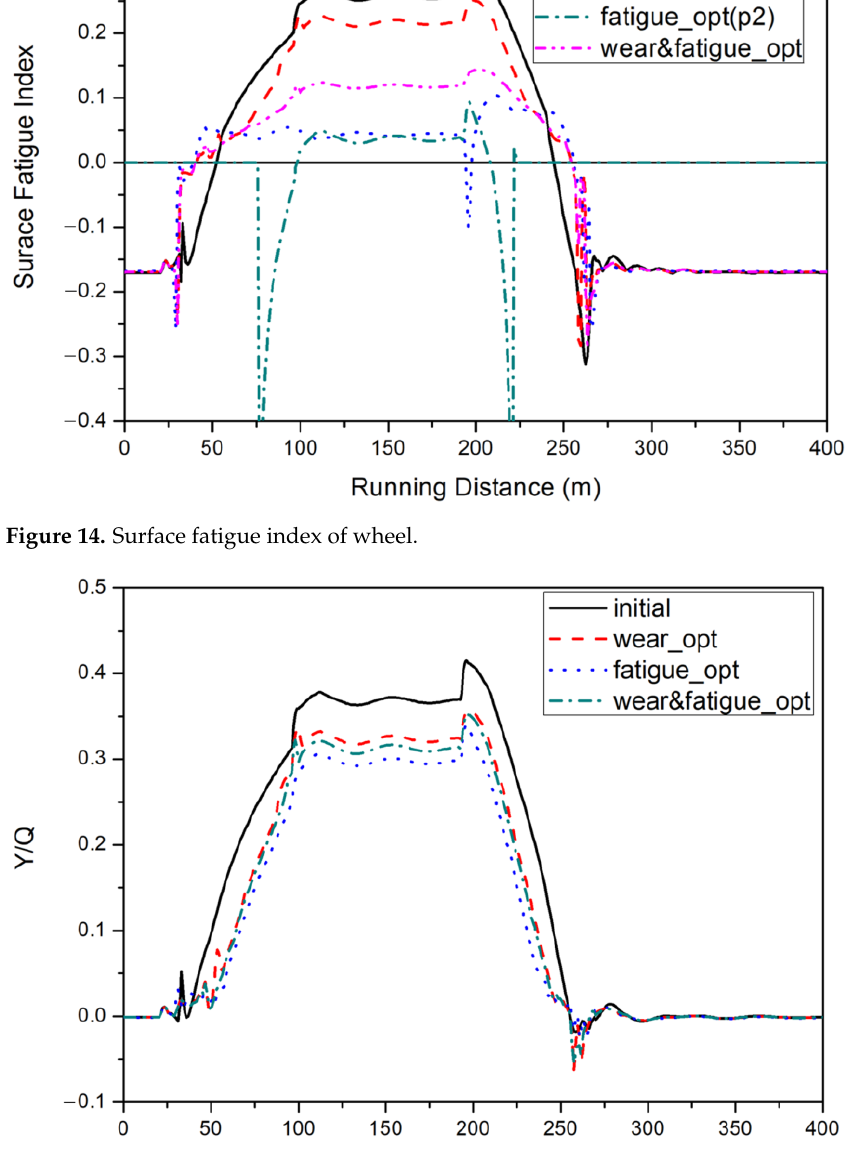
Figure 16. Lateral displacement of wheelset. The wear number, surface fatigue index, derailment coefficient, lateral pressure, and vertical force as the results of the optimization are put in order and shown in Table 3.